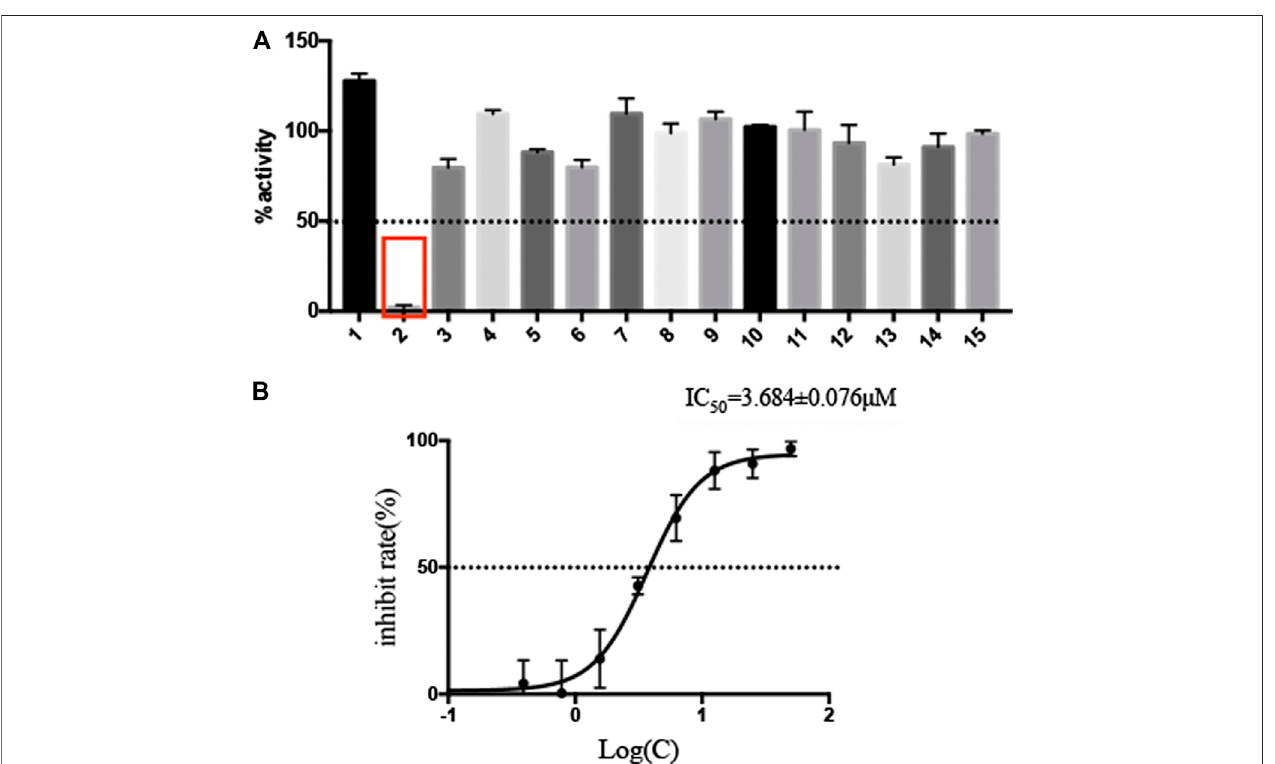
FIGURE 1 | Screening of natural compounds against SARS-CoV-2 M pro and the inhibitory activity of Myricetin in vitro . (A) . 50 μ M compound was pre-incubated with0.3 μ MSARS-CoV-2M pro at37 ° Cfor10 min,andthen20 μ MFRETsubstratewasaddedtothereactionmixturetoinitiatethereaction.Theexcitationwavelengthis 340 nmandtheemissionwavelengthis490 nmfor fl uorescencemeasurement.ResultsInhibitionrate(%) (cid:2) (RFU100%enzymeactivitycontrol-RFUsample)/(RFU100% enzyme activity control-RFU blank control) × 100%. The results are average ± standard deviation of three repeats. (B) The inhibitory assay of Myricetin show ef fi cient inhibition for M pro . Error bars: mean ± S.D. of three independent replicates.